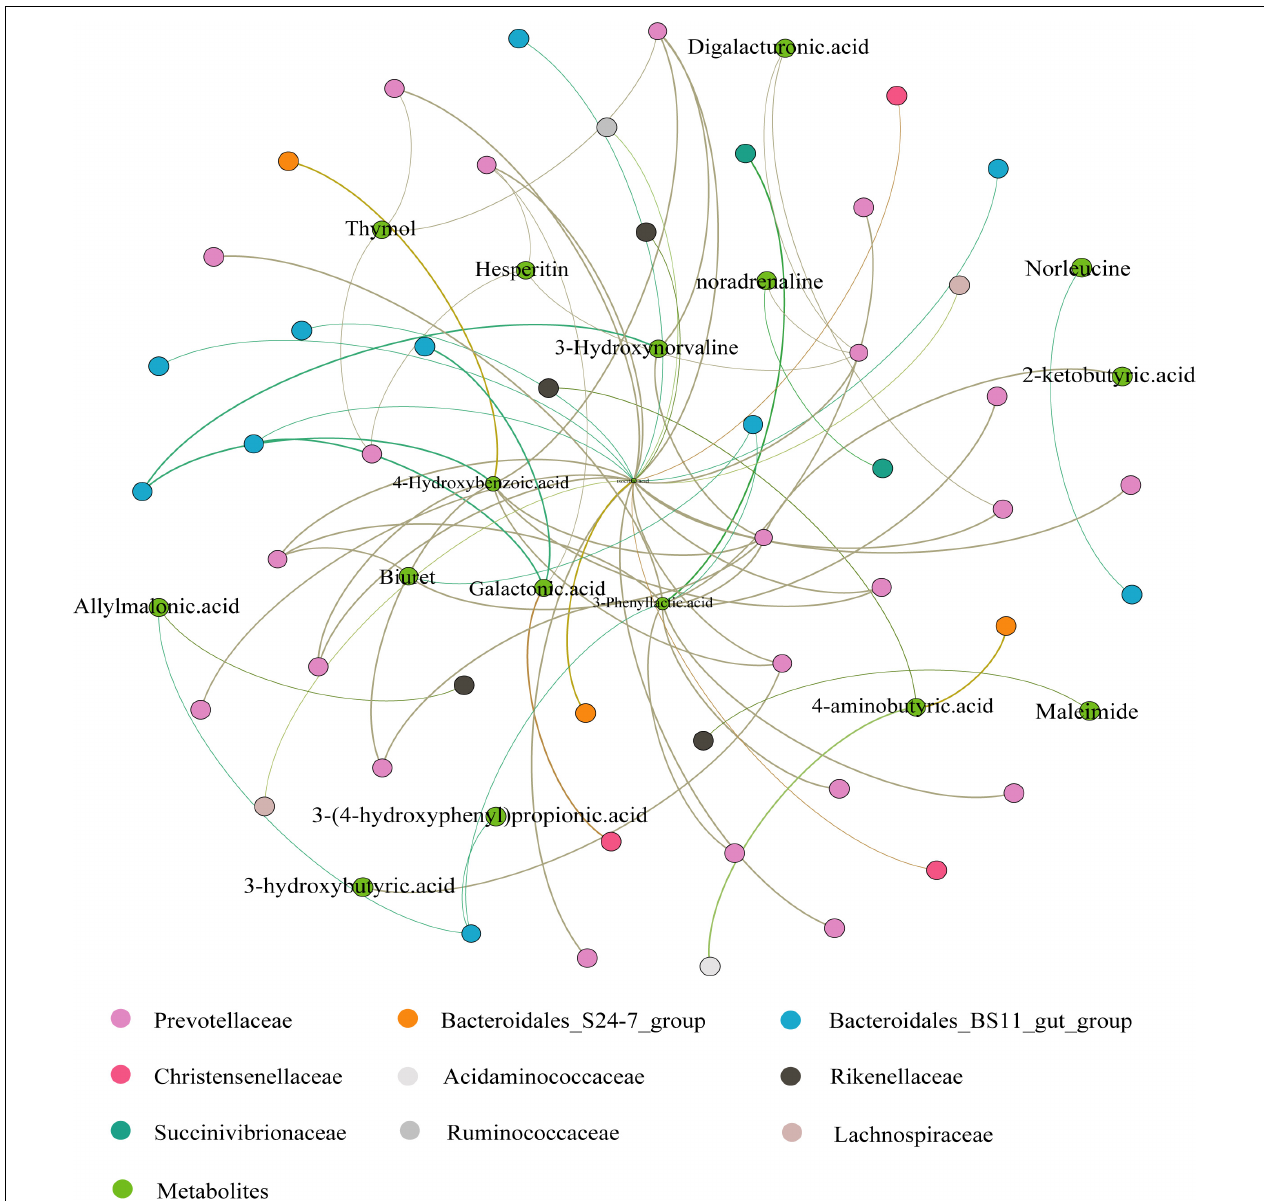
FIGURE 6 | Correlation analysis between the Ruminal Metabolome and Microbiome. The correlations were based on Spearman correlation coefficients ( p < 0.05). The brown lines to green lines provide the corresponding change from positive to negative